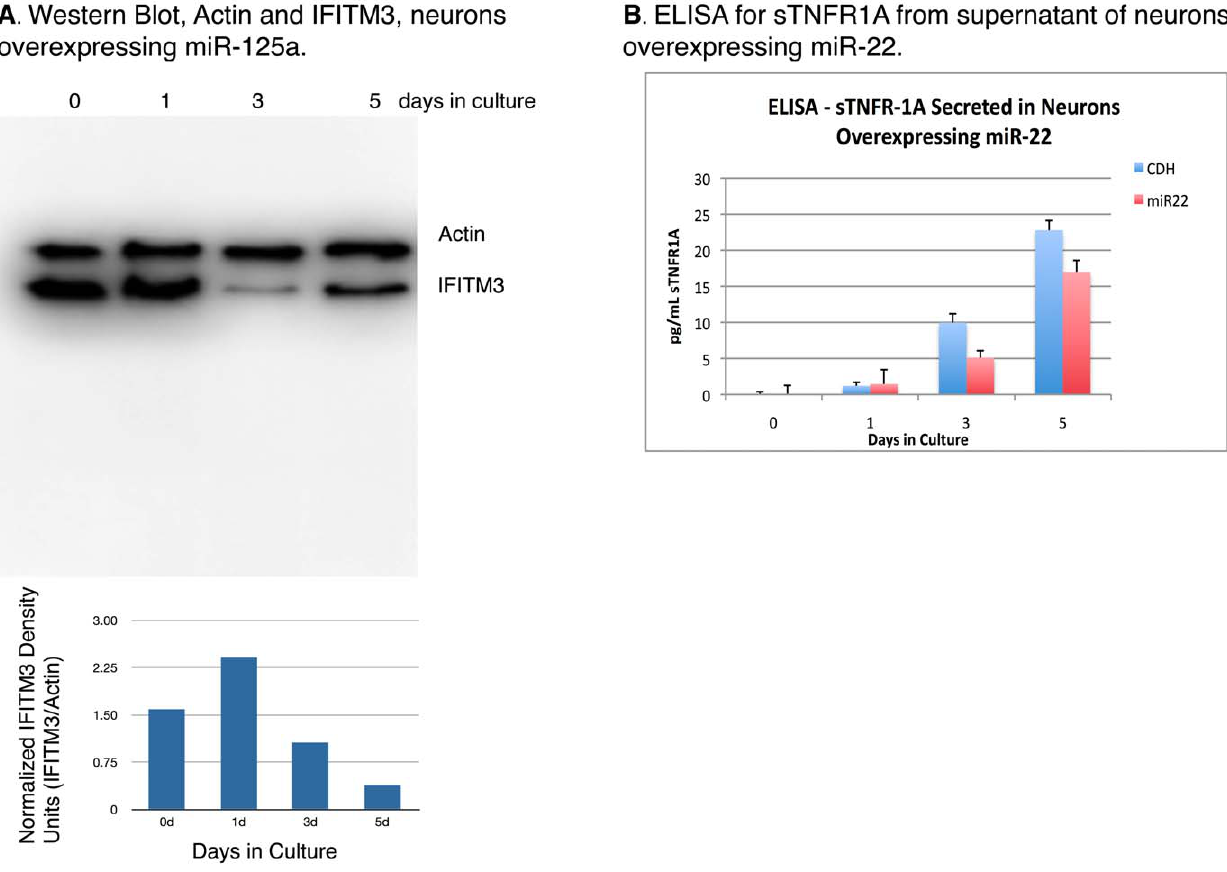
Figure 6. (A) Decreased protein production of IFITM3 in miR-125a overexpressing neuronal cells and (B) decreased secretion of sTNFR-1A in miR-22 overexpressing neuronal cultures.